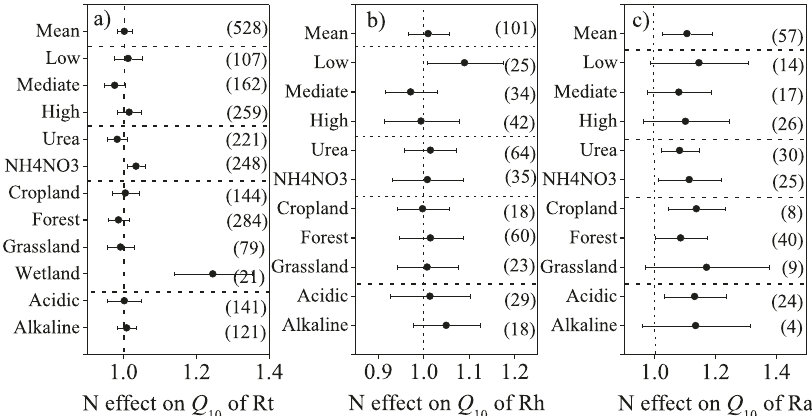
Fig. 2 In fl uence of nitrogen enrichment on the temperature sensitivity of soil respiration. Overall effect of nitrogen enrichment and the effects of nitrogen form and application rate and ecosystem types on the temperature sensitivity of total soil respiration ( a ), heterotrophic respiration ( b ), and autotrophic respiration ( c ) across all observation. Error bars represent 95% con fi dence intervals (CIs). The numbers in the brackets represent sample sizes. Signi fi cant responses ( p < 0.05) are recognized if the 95% CIs does not overlap with zero. Vertical dashed lines are the reference of the nitrogen effect of 1.0.